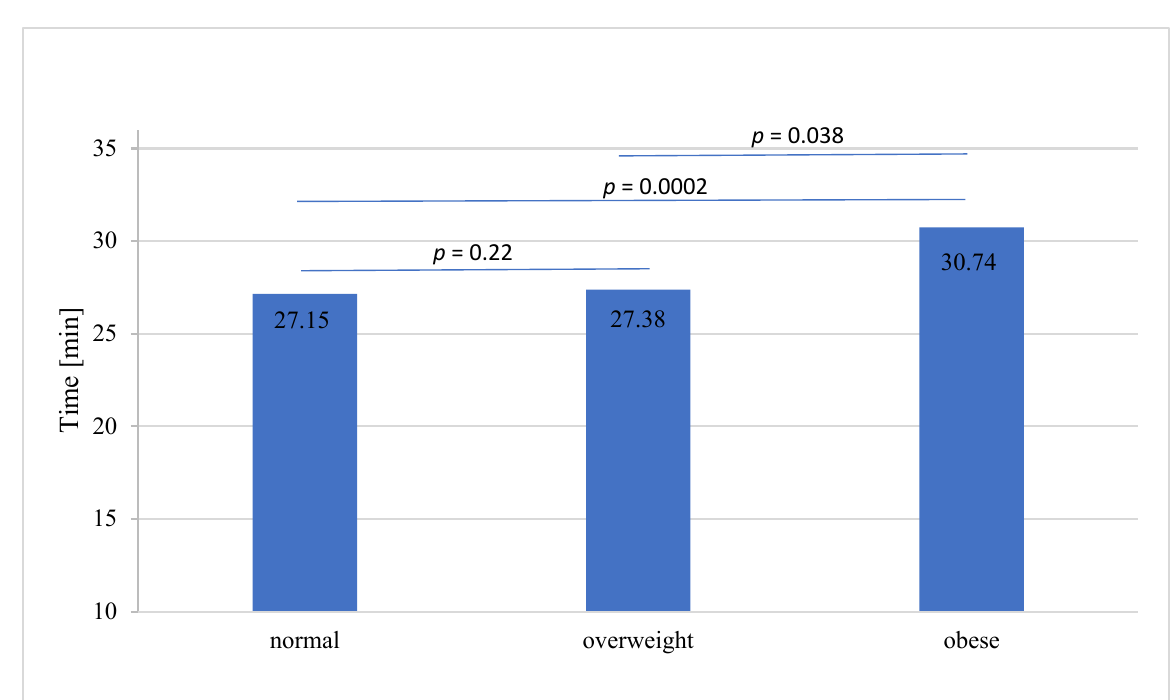
Figure 1. Total procedure time in BMI stratified groups.